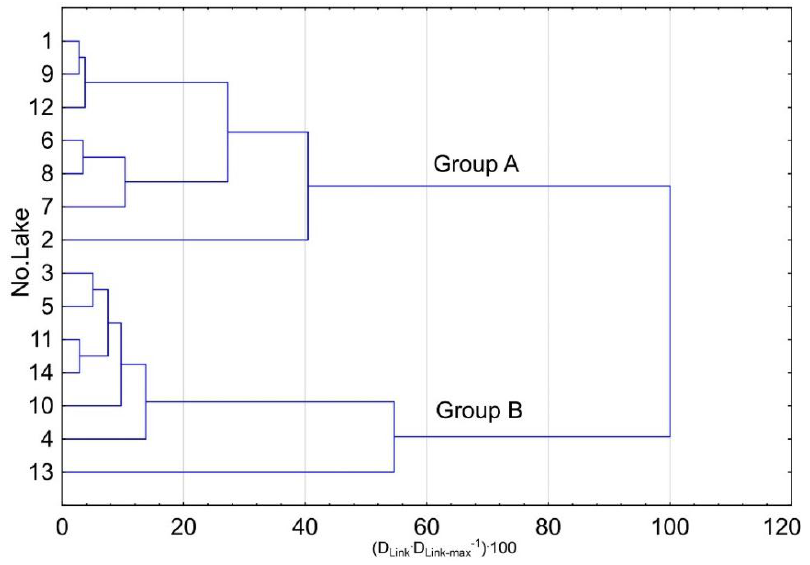
Figure 5. Grouping of lakes based on temperature trends.